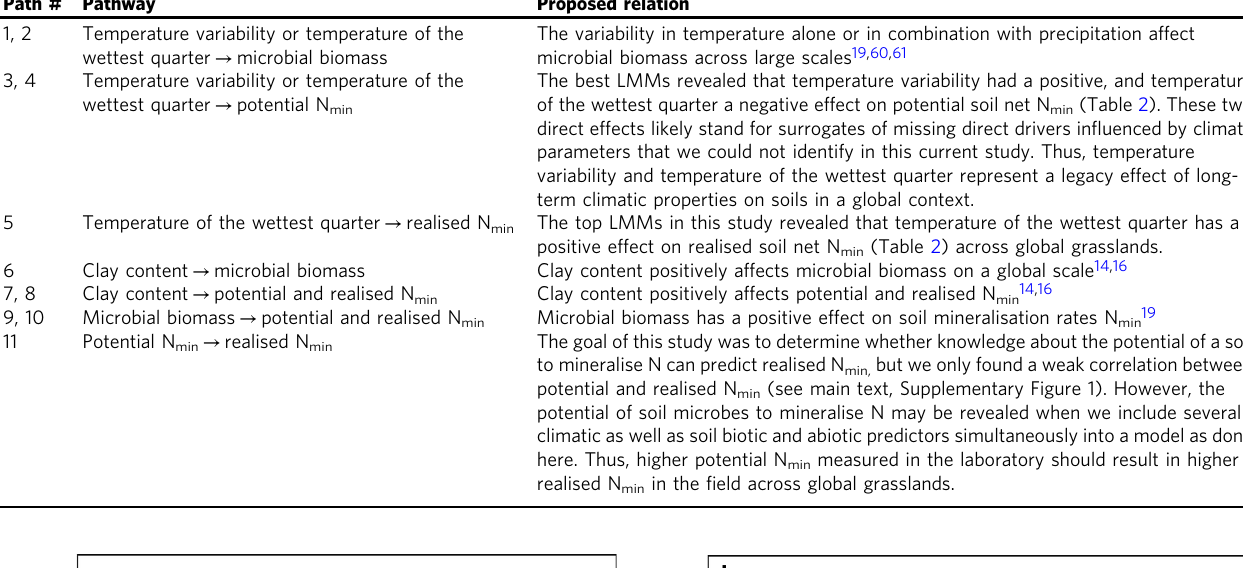
Table 1 Potential relationships between variables derived from the literature and the linear mixed effects model results (see Table 2) Path # Pathway